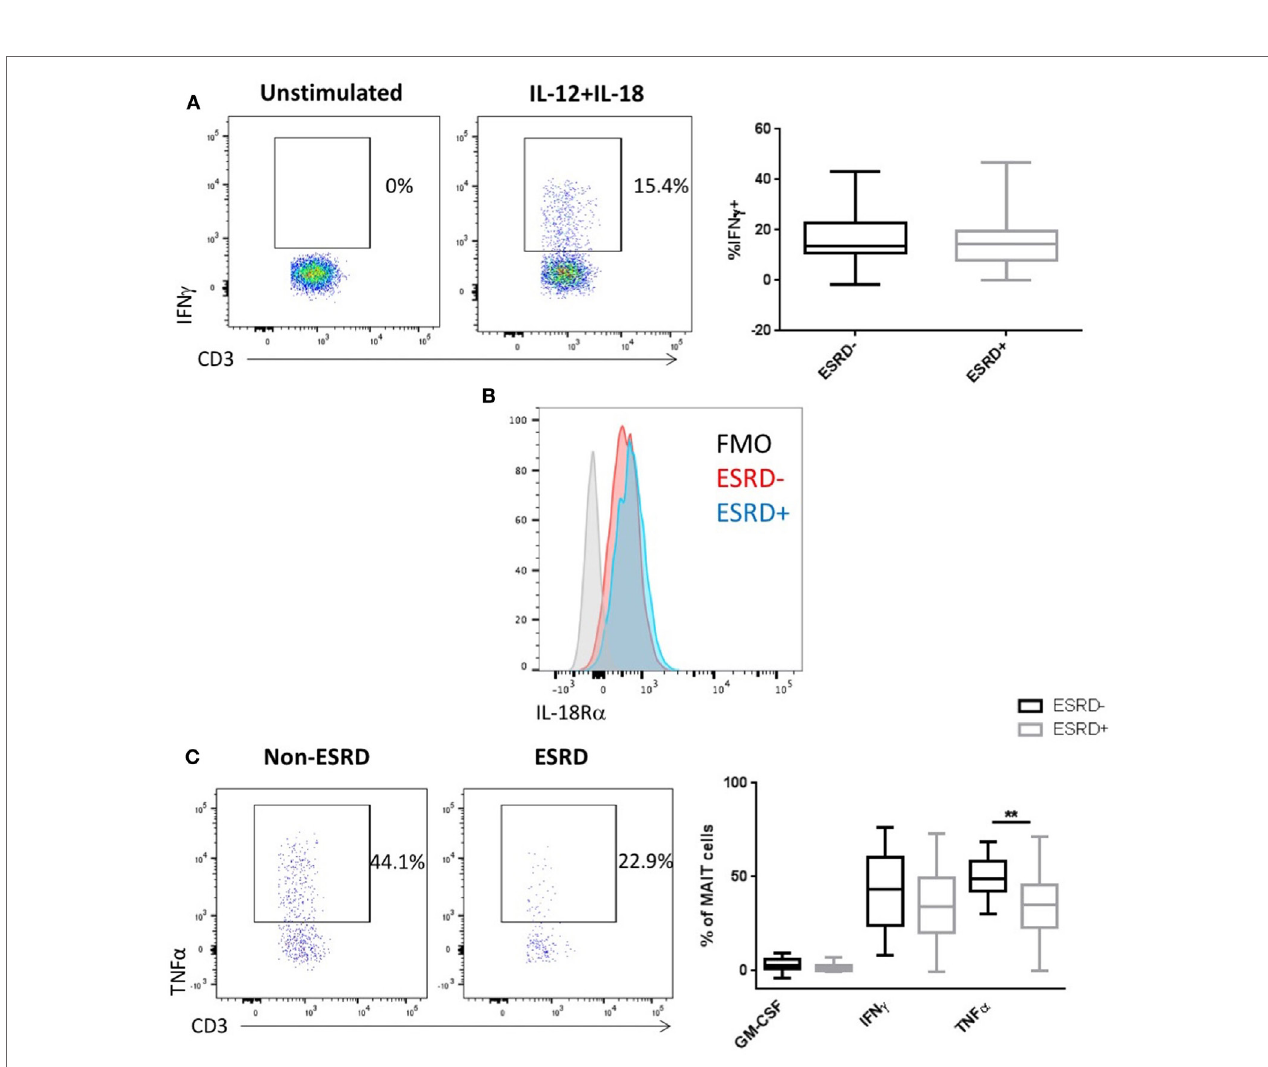
FigUre 6 | Mucosal-associated invariant T (MAIT) cell (CD4 − V α 7.2 + CD161 ++ ) responses to IL-12/IL-18 and Escherichia coli stimulation [ n = 19 end-stage renal disease (ESRD) − , n = 18 ESRD + ]. (a) Representative staining of IFN γ expression in an unstimulated control and IL-12/IL-18 stimulated sample, as well as a comparison of IFN γ production following 24 h IL-12/IL-18 stimulation between ESRD and non-ESRD groups. (B) Representative staining of IL-18Ra expression on MAIT cells in an ESRD and non-ESRD control sample as well as the fluorescent minus one (FMO) control. (c) Comparison of granulocyte macrophage-colony stimulating factor, IFN γ , and tumor necrosis factor α (TNF α ) production following stimulation with E. coli and IL-15 between ESRD and non-ESRD groups. Representative staining shows TNF α production in response to stimulation in a non-ESRD and ESRD participant. Comparisons performed by Mann–Whitney test, ** p < 0.01.